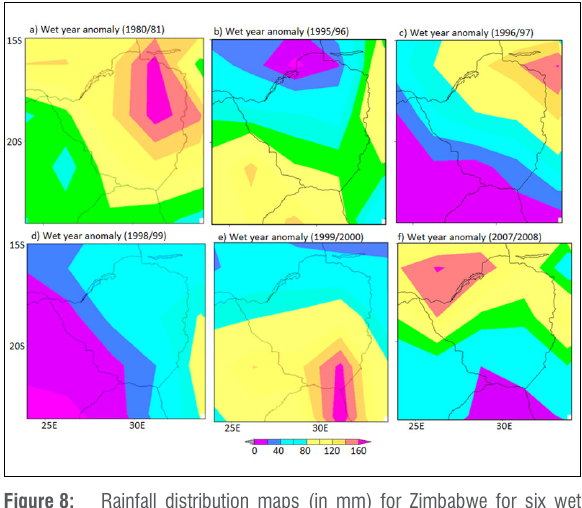
Figure 10: Rainfall distribution maps (in mm) for Zimbabwe for six dry years over the December–February months.